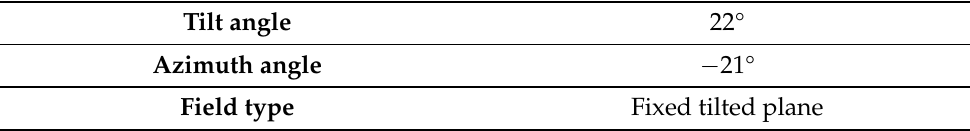
Table 1. Orientation Parameters Selected In the PV